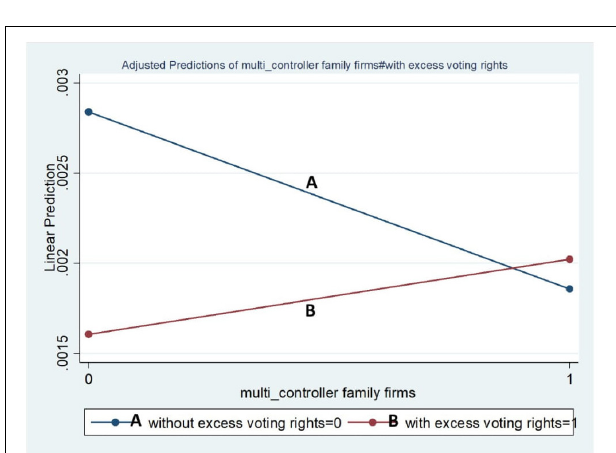
FIGURE 2 | Moderating effect of voting rights on MCFF-R&D investment.